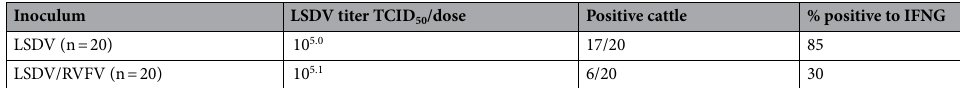
Table 1. Interferon Gamma Bovigam assay in cattle vaccinated with LSDV and RVFV/LSDV.